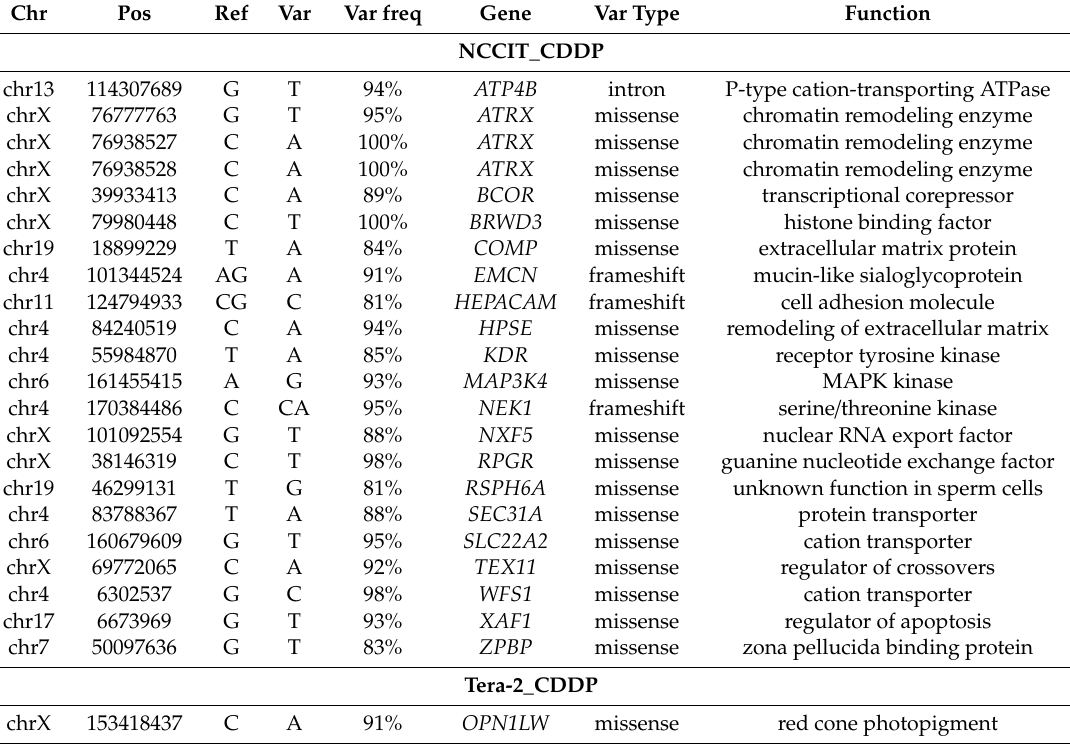
Table 1. Newly acquired variants detected by whole exome sequencing (WES) in CDDP-treated cells in comparison to the original cell